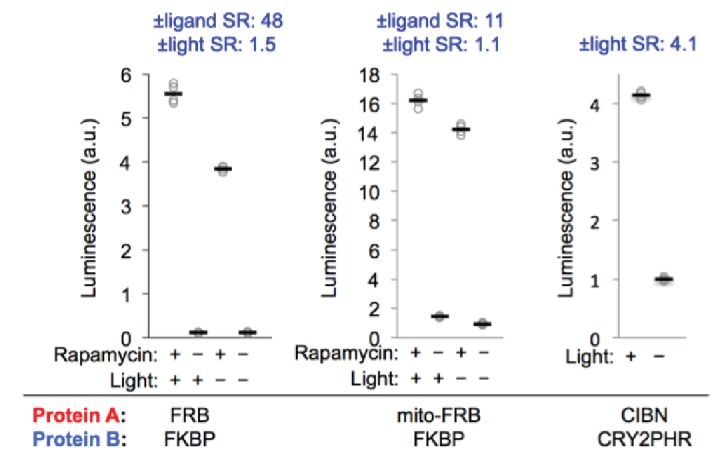
Additional data with FRB-FKBP and CIBN-CRY2PHR SPARK constructs.The SPARK constructs from Figure 2B and C were co-expressed in HEK293T cells with UAS-luciferase reporter gene to facilitate quantification. Stimulation conditions were the same as in Figure 2B and C, and cells were treated with luciferin 9 hr later. We performed four replicates per condition. ±Ligand signal ratios (SR) and ±light SR are quantified across the top.